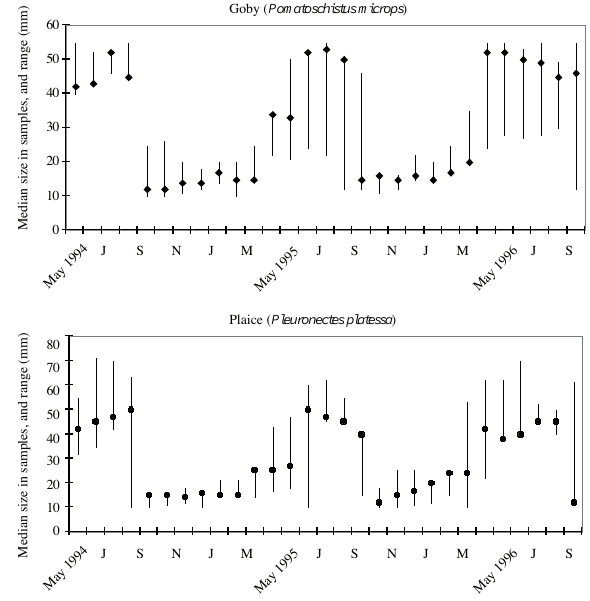
F IG . 2. – Median size of overwintering fish (the common goby Pomatoschistus microps and the plaice Pleuronectes platessa) in Culbin Sands lagoon, NE Scotland, during the period